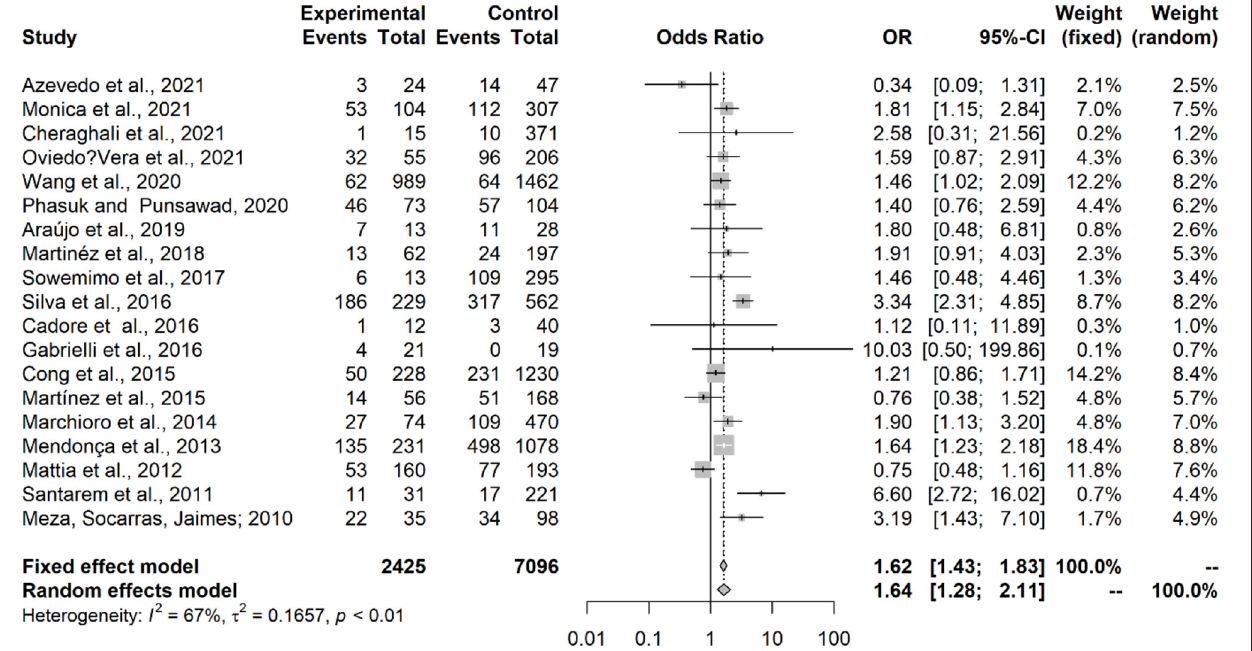
East, 1,819 (8.9%) from Europe, 721 (3.5%) from Africa, and 177 (0.9%) from Southeast